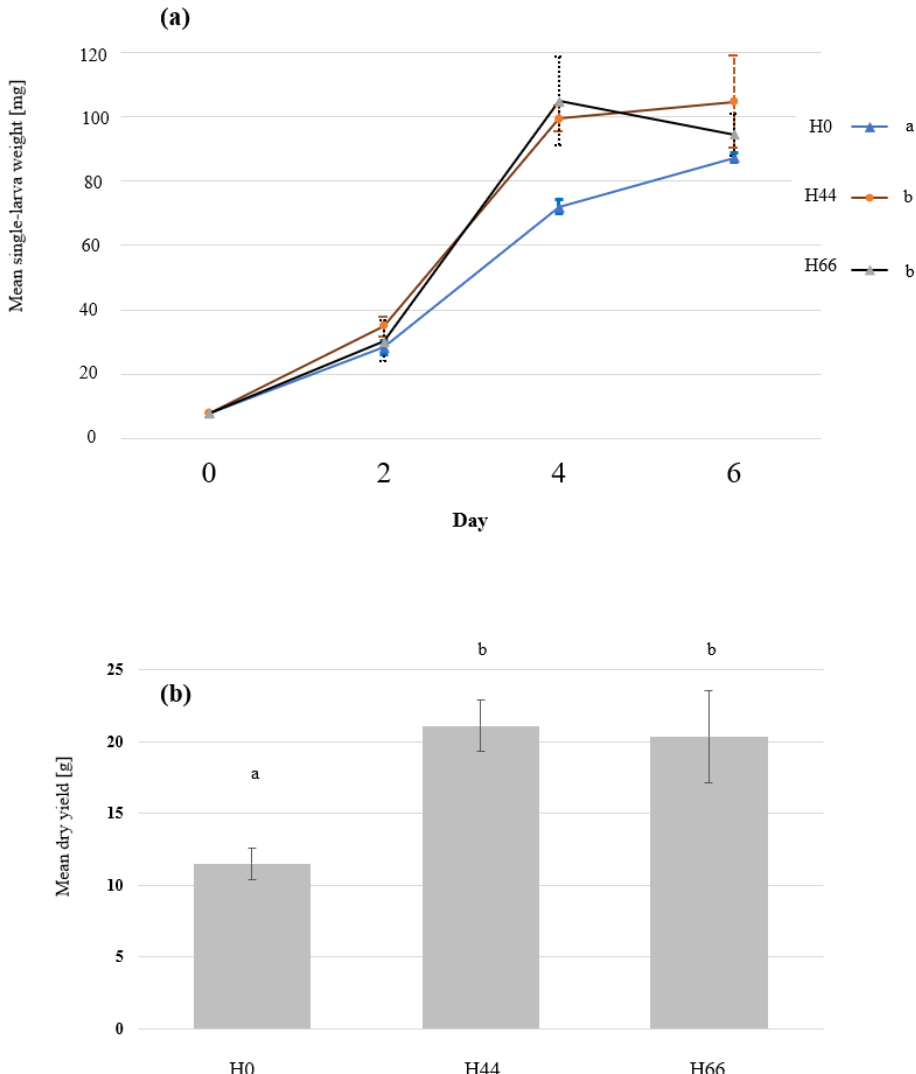
Figure 1. The growth and the final dry yield of black soldier fly larvae (BSFL) grown on substrates that contain different ratios of hemp material. BSFL were grown on substrates with 0% hemp (H0), 44% hemp (H44), 66% hemp (H66). The means and standard deviations of ( a ) the single-larva fresh weight over time and ( b ) the final dry yield are shown in the graph. Repeated measures ANOVA, and one-way ANOVA followed by Tukey’s test revealed significant differences in the larval growth over time (n = 5, p < 0.001, F = 26.8) and final dry yield (n = 5, p < 0.001, F = 28.5), respectively. Significant groups are indicated by the different